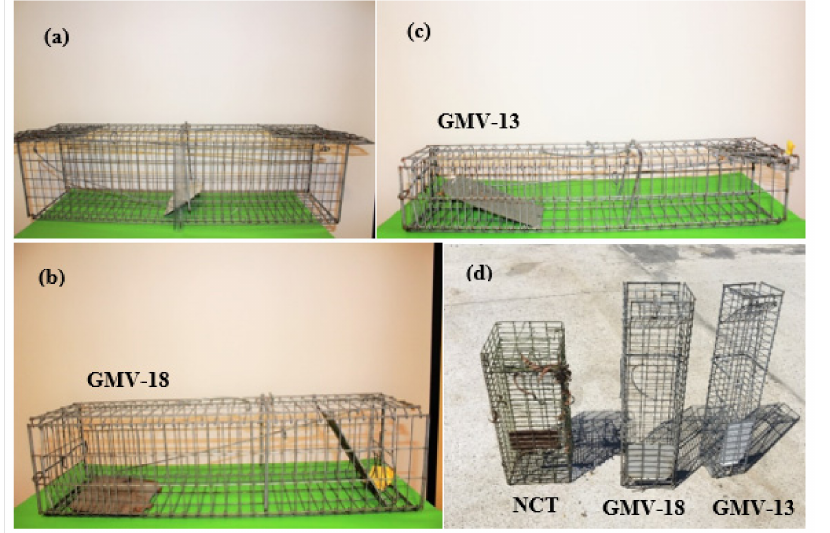
Figure 2. ( a ) Collapsible trap used in the 2010–2013 campaign (Medina- Vogel et al. [41]), ( b ) trap GMV-18 and ( c ) trap GMV-13, ( d ) comparison between GMV-18, GMV-13 and shorter non collapsible trap (NCT) used in Los Rios district, Chile by the regional program to control mink, showing the extended trap length and narrower spacing of bars in the trigger rear section of the GMV-13 and GMV-18, and the smaller width and height of the GMV-13. The GMV traps were non-commercial designs developed by our research team. Table 1. Transect details and trapping results presented by river basin. TN =